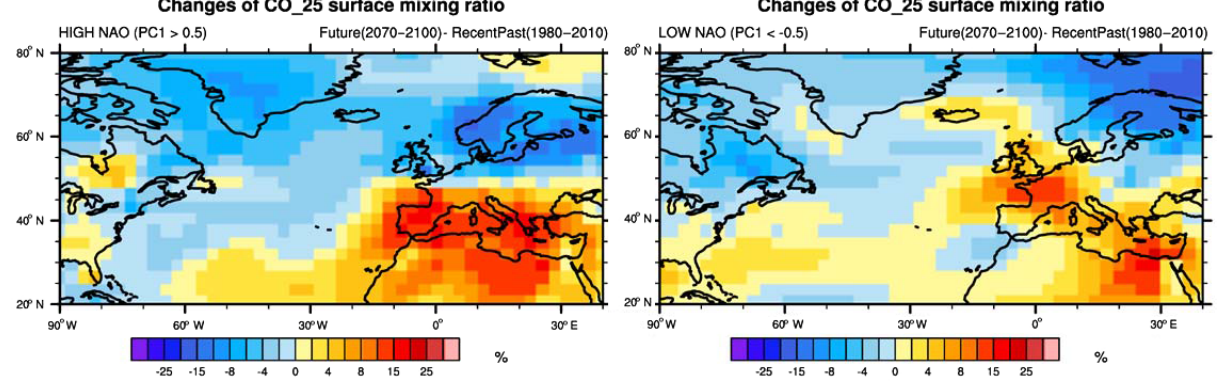
Figure 6. Differences between future (2070–2100) and recent past (1980–2010) temporal averages of CO_25 winter surface mixing ratio, both in the case of high NAO (PC1 > 0.5) (left) and low NAO (PC1 < − 0.5) (right). More precisely, plots show the results of [ ( CO_25 fut ave − CO_25 past ave )/ CO_25 past ave ]× 100, so the coloured bars indicate the